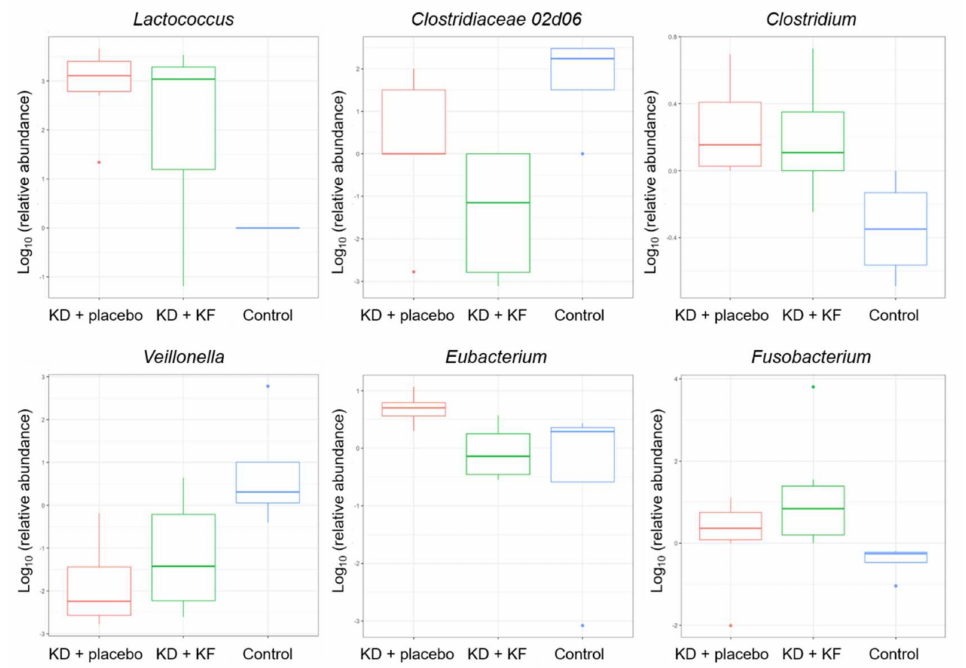
Figure 7. Comparison of gut microbiota composition between groups. Red bar, KD + placebo group; green bar, KD + KF group; blue bar, control